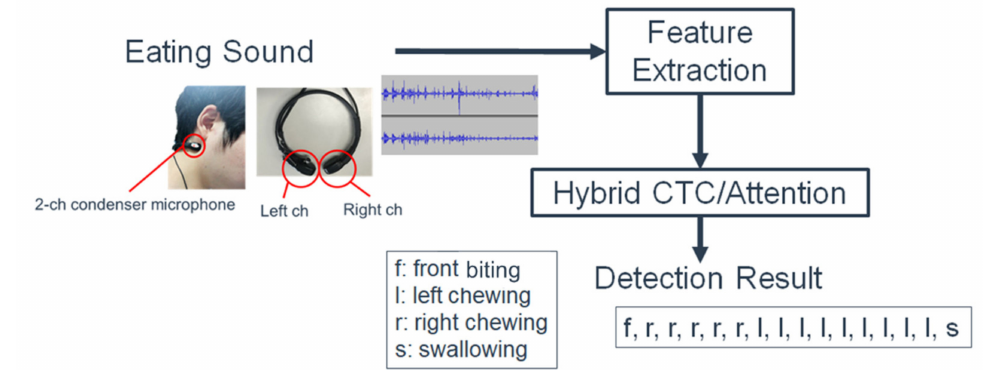
Figure 1. The automatic detection system of left chewing, right chewing, front biting, and swallowing.